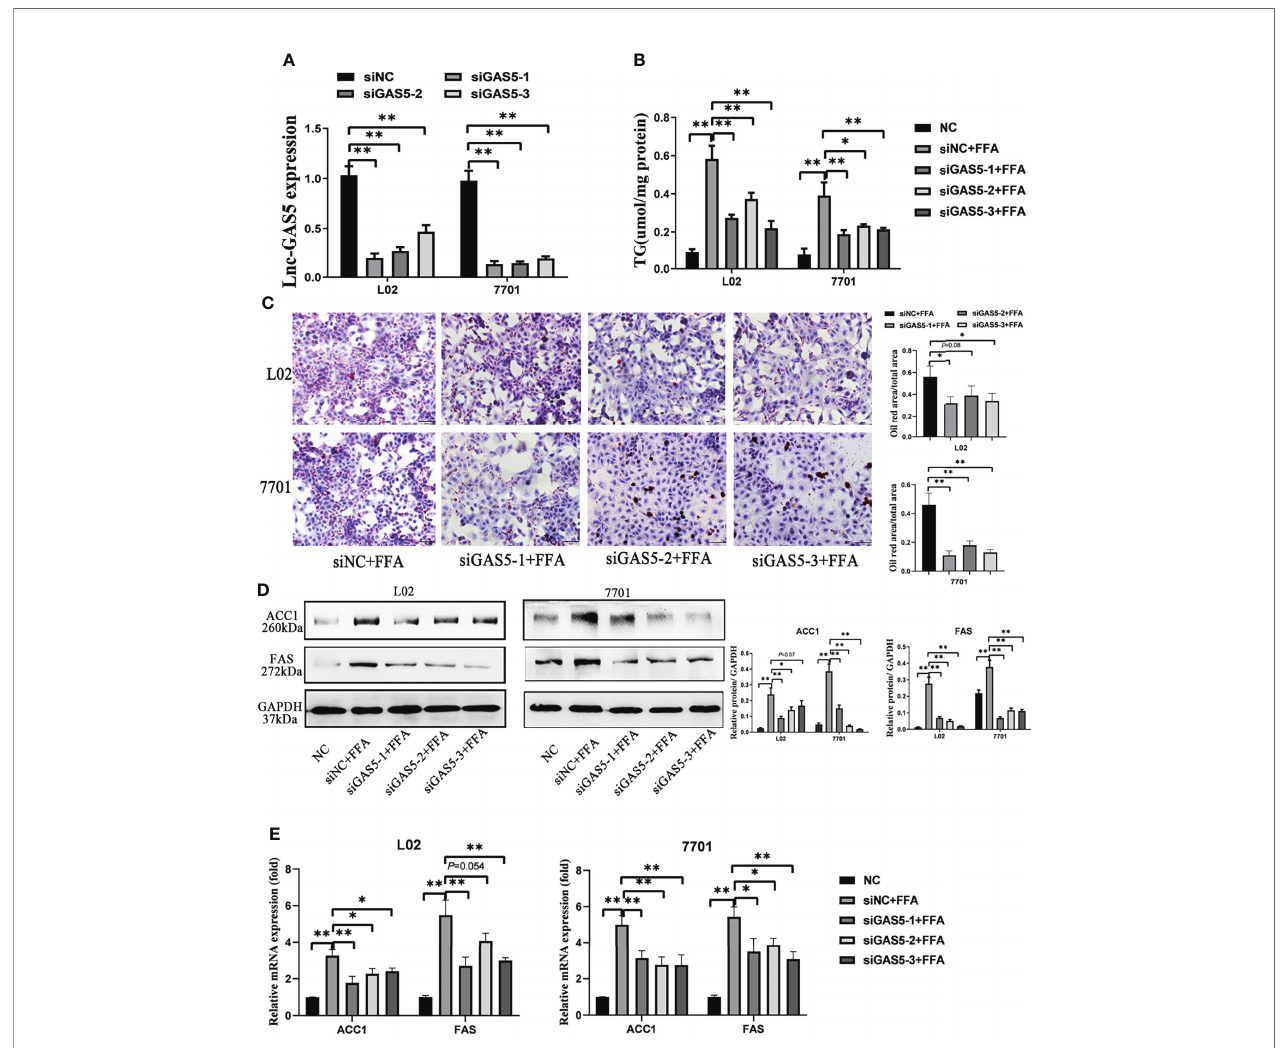
FIGURE 3 | Long non-coding RNA growth arrest speci fi c 5 (GAS5) knockdown mitigates cellular de novo lipogenesis. After cells were transfected with three synthetic small interfering RNAs, the expression of lnc-GAS5 were determined using quantitative real-time polymerase chain reaction analysis (RT-qPCR) (A) and lipid accumulation in cells were assessed via oil red staining (Original magni fi cation, ×200) (B) . The cellular triglyceride levels were detected using commercial kits (C) , and the protein and mRNA levels of ACC1 and FAS were measured via western blot and RT-qPCR, respectively (D, E) . Data are expressed as mean ± standard error of mean. * P <0.05, and ** P <0.01, n =